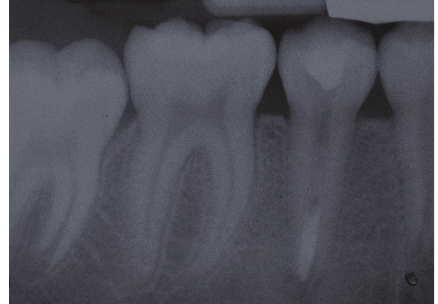
Figure 1: Clinical photograph of tooth 45 with an occlusal restoration of the access cavity and fractured dens evaginatus tubercle of tooth 35.